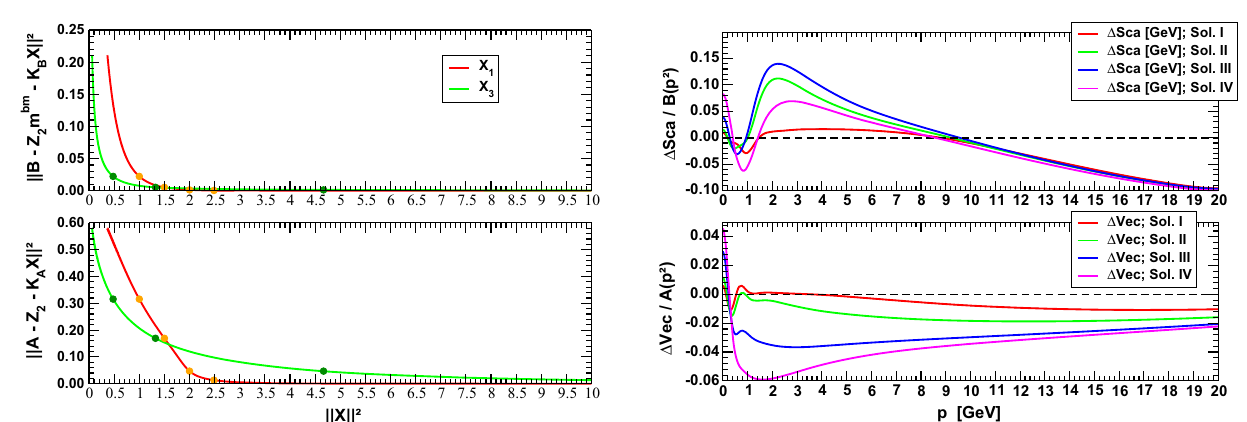
Fig. 24 Residua versus norm of the form factors from inverting the Dyson–Schwinger equations with X 0 = 1